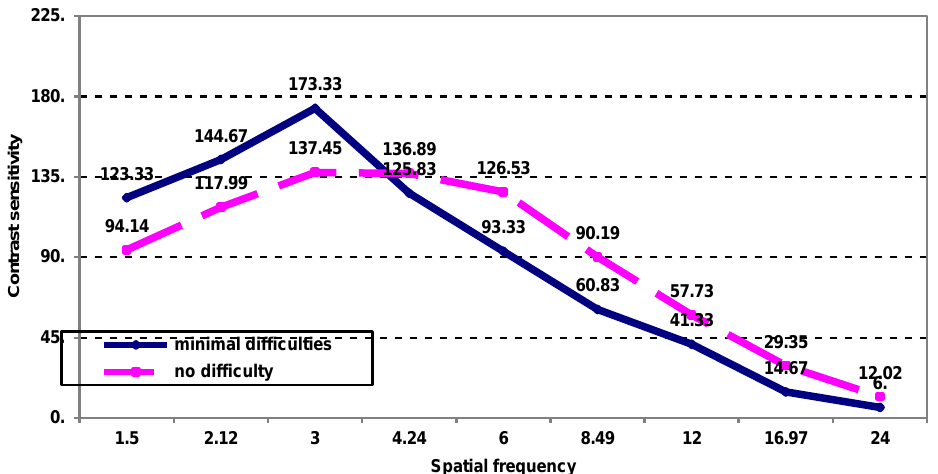
Figure 4. The contrast sensitivity as a function of spatial frequency in patients who have minimal post-treatment difficulties during their favorite activities. Table 9. The percentage distribution of patients with visual difficulties in daily activities according to pre- and post-treatment study group